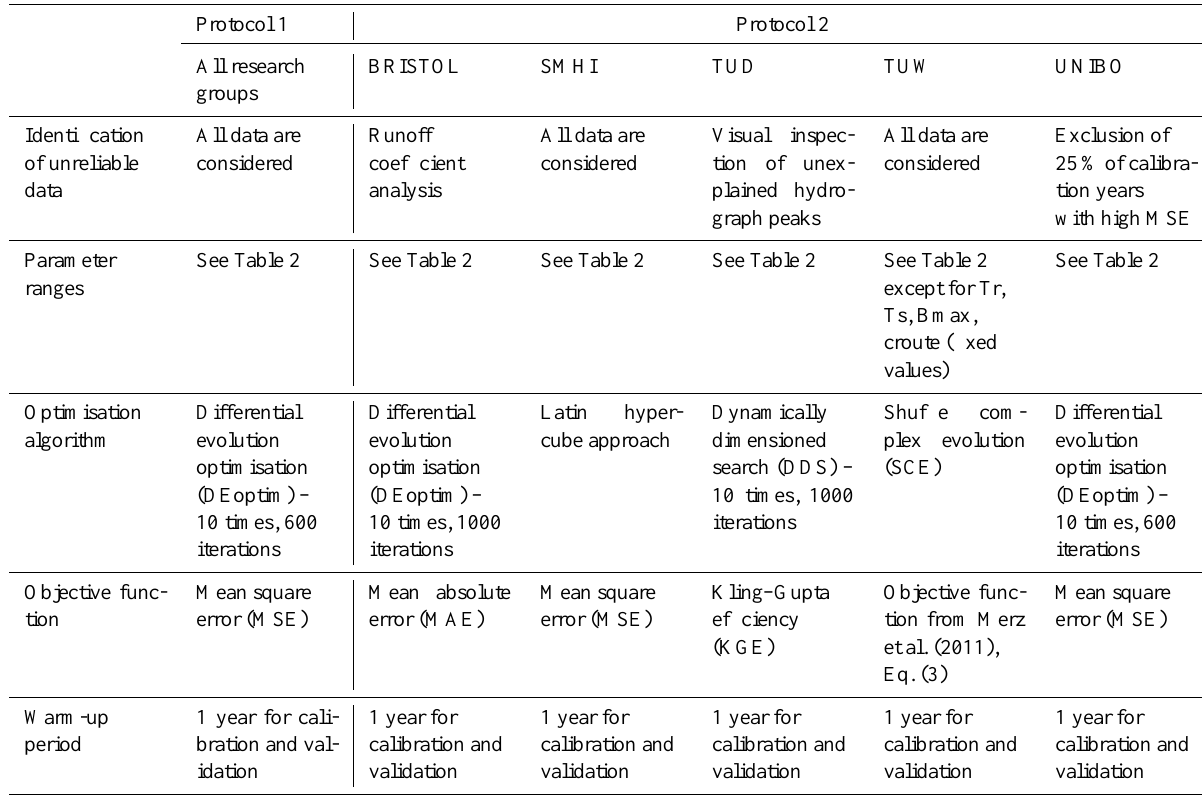
Table 3. Comparison among Protocol 1 and Protocol 2 settings of the first collaborative experiment of the SWITCH-ON Virtual Water- Science